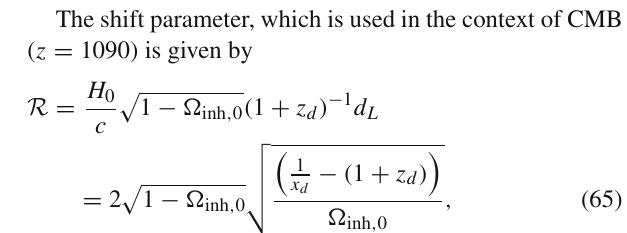
Fig. 4 v = r s / D V with respect to the redshift z , with various of values (cid:17) inh , 0 . The top curve (red) corresponds to (cid:17) = 0 . 9998, the middle inh , 0 curve (black) corresponds to (cid:17) = 0 . 7200, and the bottom inh , 0 curve (green) corresponds to (cid:17) = 0 . 0041. Since (cid:17) inh , 0 can only take values between 0 and 1, this means the model cannot fit observational